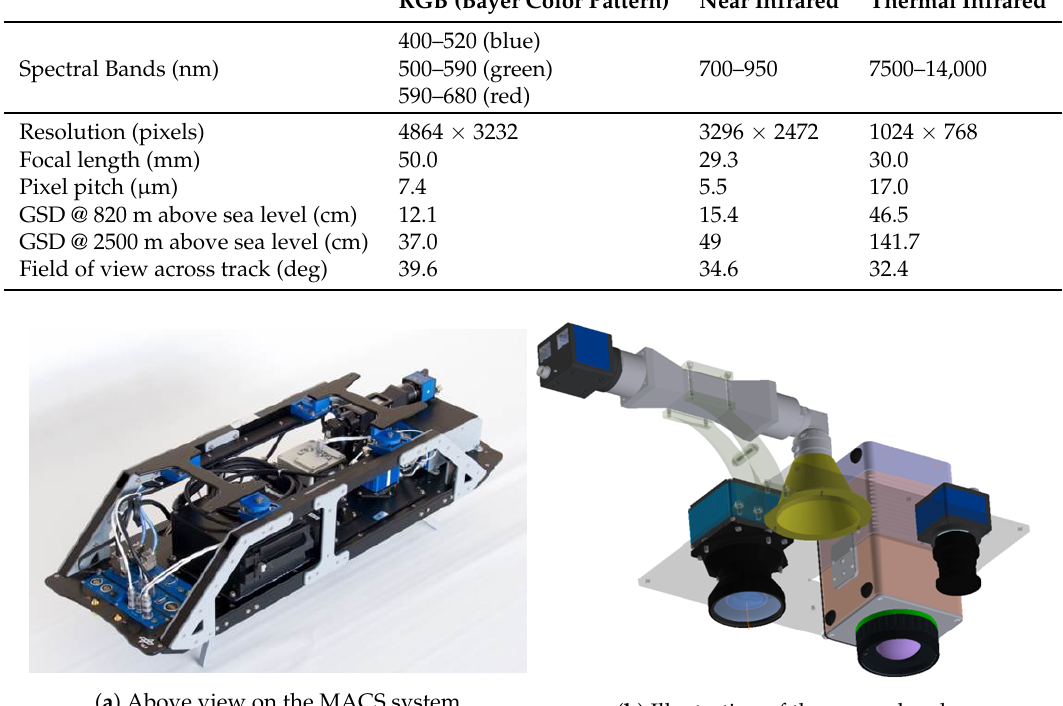
Figure 5. Modular Aerial Camera System